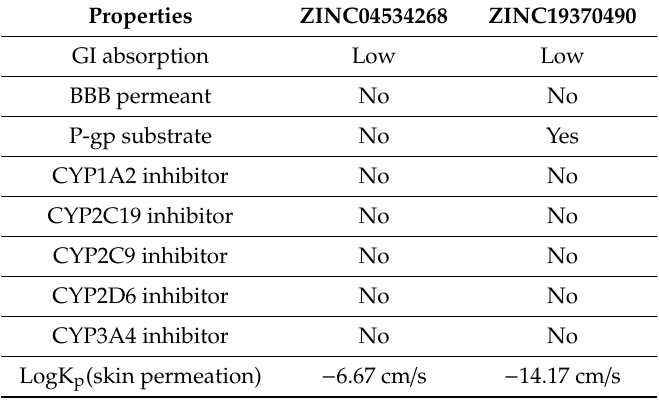
Table 6. General properties of ZINC04534268 and